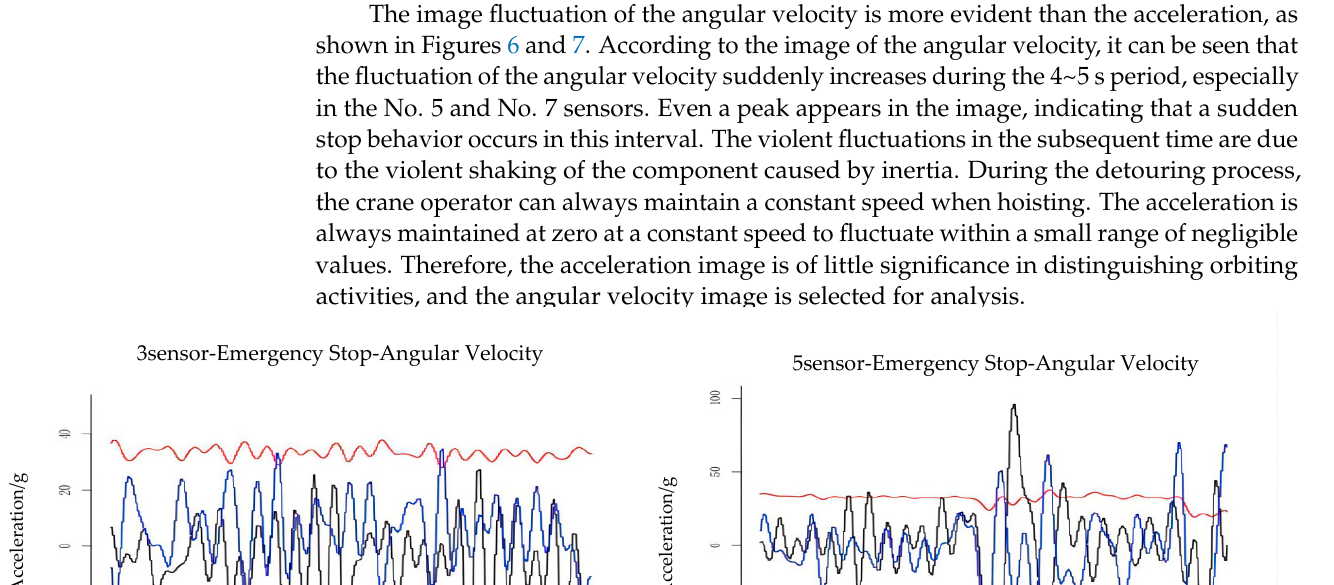
Figure 5. Acceleration graph at the sudden stop.